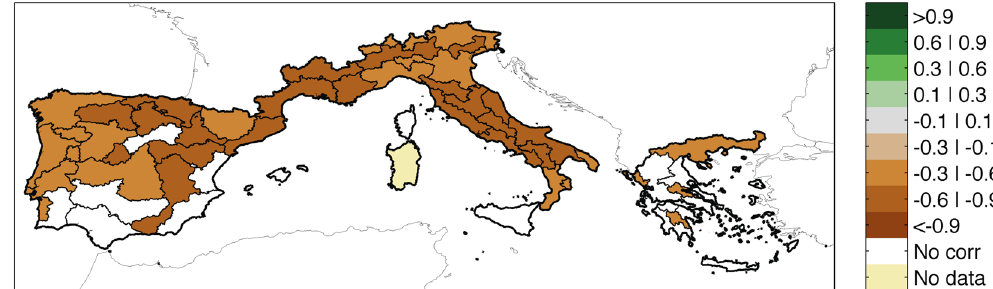
Figure 1. Correlations between detrended log( BA ) and SPEI 3 (0, 8), the SPEI for an accumulation time scale of 3 months and calculated in August (8) of the coincident summer (i.e. with the time lag of 0 year). Only correlations that are collectively significant from an FDR test 45 are shown. This figure is created with Matlab version R2012a (http://www.mathworks.com/).